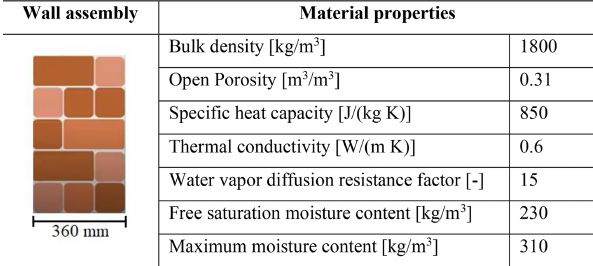
Table 1. Simulated masonry wall and its material properties, de- rived from the WUFI ® material